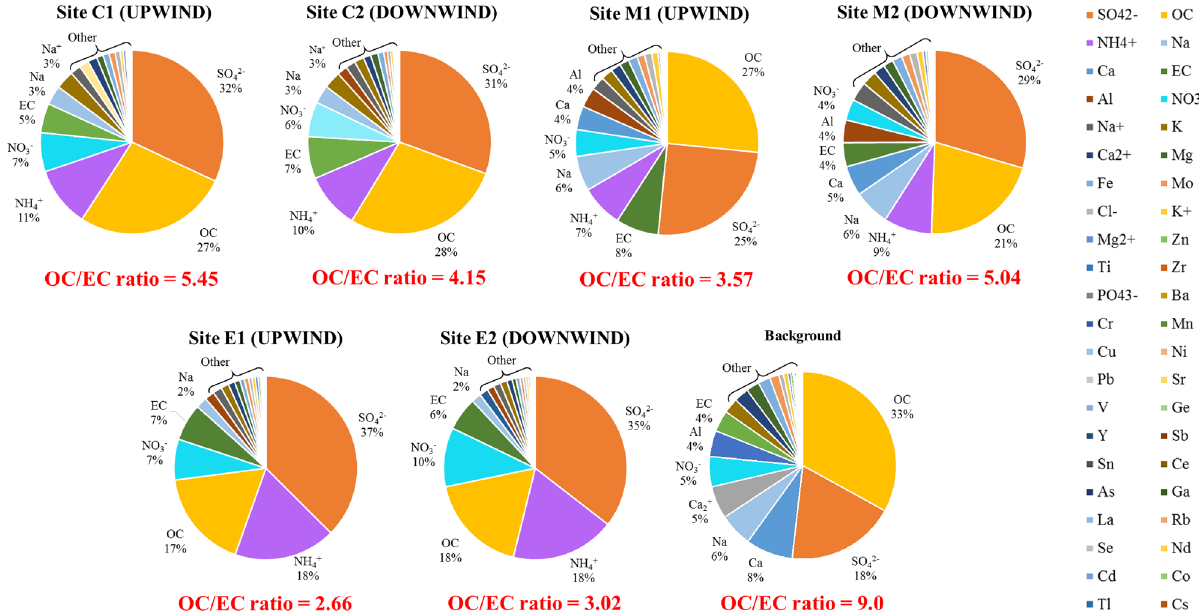
Figure 2. The percentage of atmospheric chemical species in PM 2.5 in the vicinity of stationary emission sources.